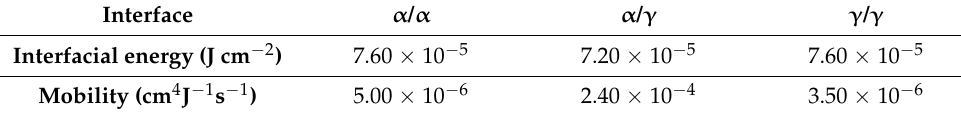
Table 3. Interfacial parameters between ferrite ( α ) and austenite ( γ )